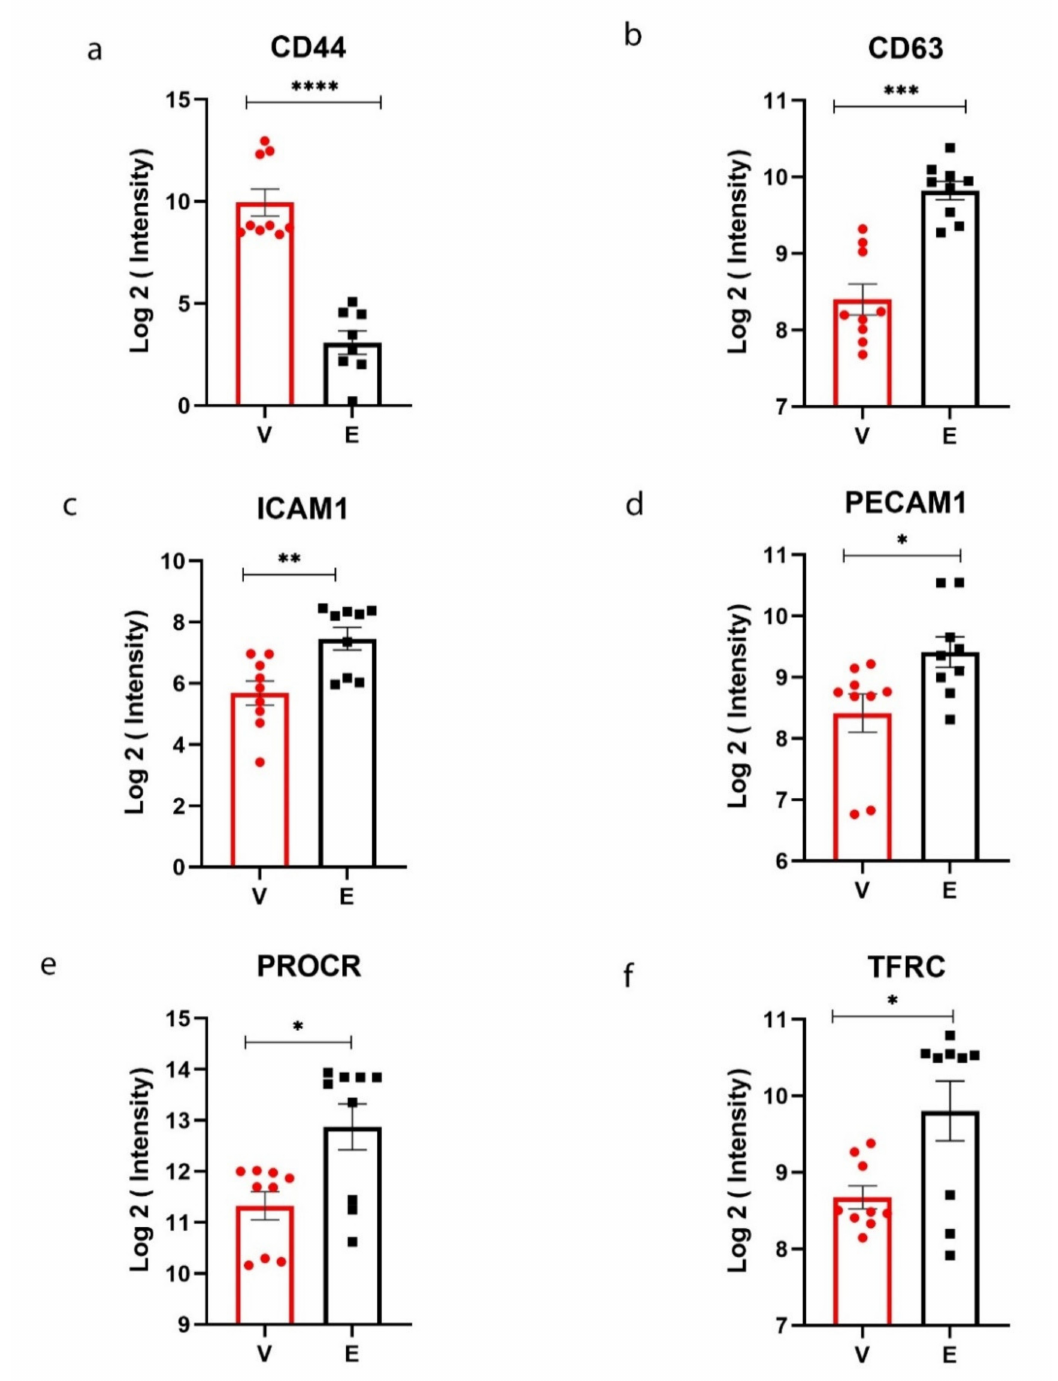
Figure 3. Cell surface markers identified in aortic valvular (AVE)and endocardial endothelium (EE). The GSEA analysis was used to determine the cell differentiation (CD) markers. The CD-marker highly expressed in AVE cells was represented in ( a ). The CD-markers highly expressed in EE cells were shown in ( b – f ). Cell The normalized peptide intensities from label-free proteomics data were used to create the graphs. The Student’s t -test was used for the differential expression analysis using Progenesis QI for Proteomics. A protein with a raw p -value < 0.05 and fold change > 1.5 was considered significant. V—Valvular endothelial cells; E—Endocardial endothelial cells. * p -value < 0.05, ** p -value < 0.01, *** p -value < 0.001 and **** p -value <